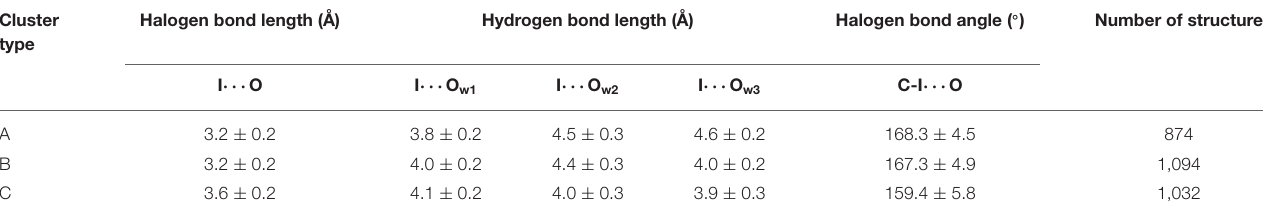
TABLE 1 | Average values and standard deviations of key parameters and number of structures of three clusters. Cluster